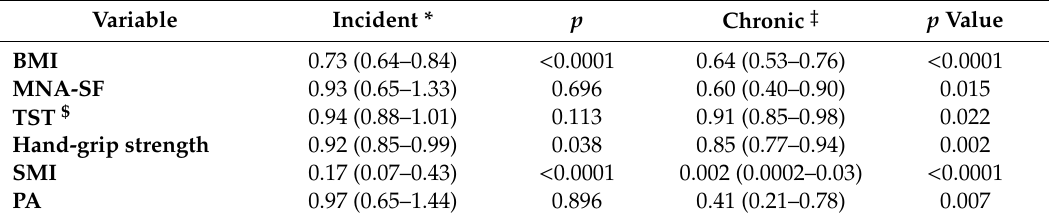
Table 3. Logistic regression analysis considering incident or chronic sarcopenia as dependent